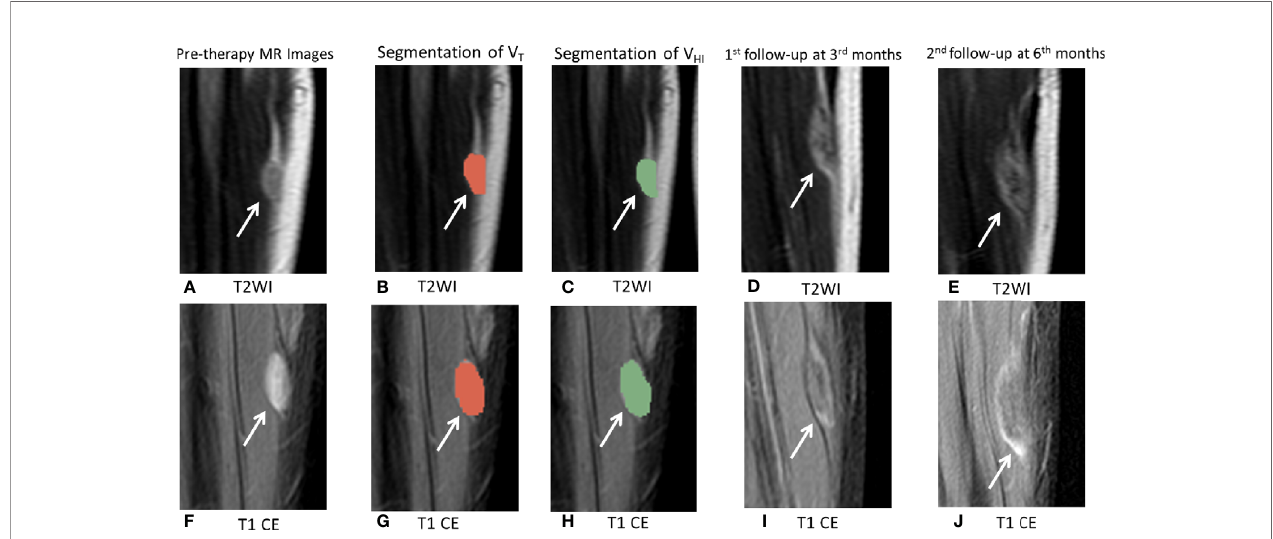
FIGURE 7 | MRI images in a 18-year-old male patient with DF of left calf muscle with imatinib treatment (arrows). Pre-therapy (A, F) diameter, 21.0 mm; On T2WI, V T = 5,477 mm 3 , V HI = 418 mm 3 , HI = 7.5% (grade = 0); On T1 CE, V T = 5,238 mm 3 , V HI = 5,238 mm 3 , HI = 100% (grade = 3). Segmentation of V T ( B, G , red zonex) and segmentation of V HI ( C, H , green zone). First follow-up at 3 months since treatment with imatinib (D, I) diameter, 25.0 mm indicates a 19.0% increase in tumor size. The tumor response assessment is SD, according to RECIST1.1. Second follow-up at 5 months since treatment with imatinib (E, J) diameter, 36.0 mm indicates a 71.4% increase in tumor size. The tumor response assessment is PD, according to